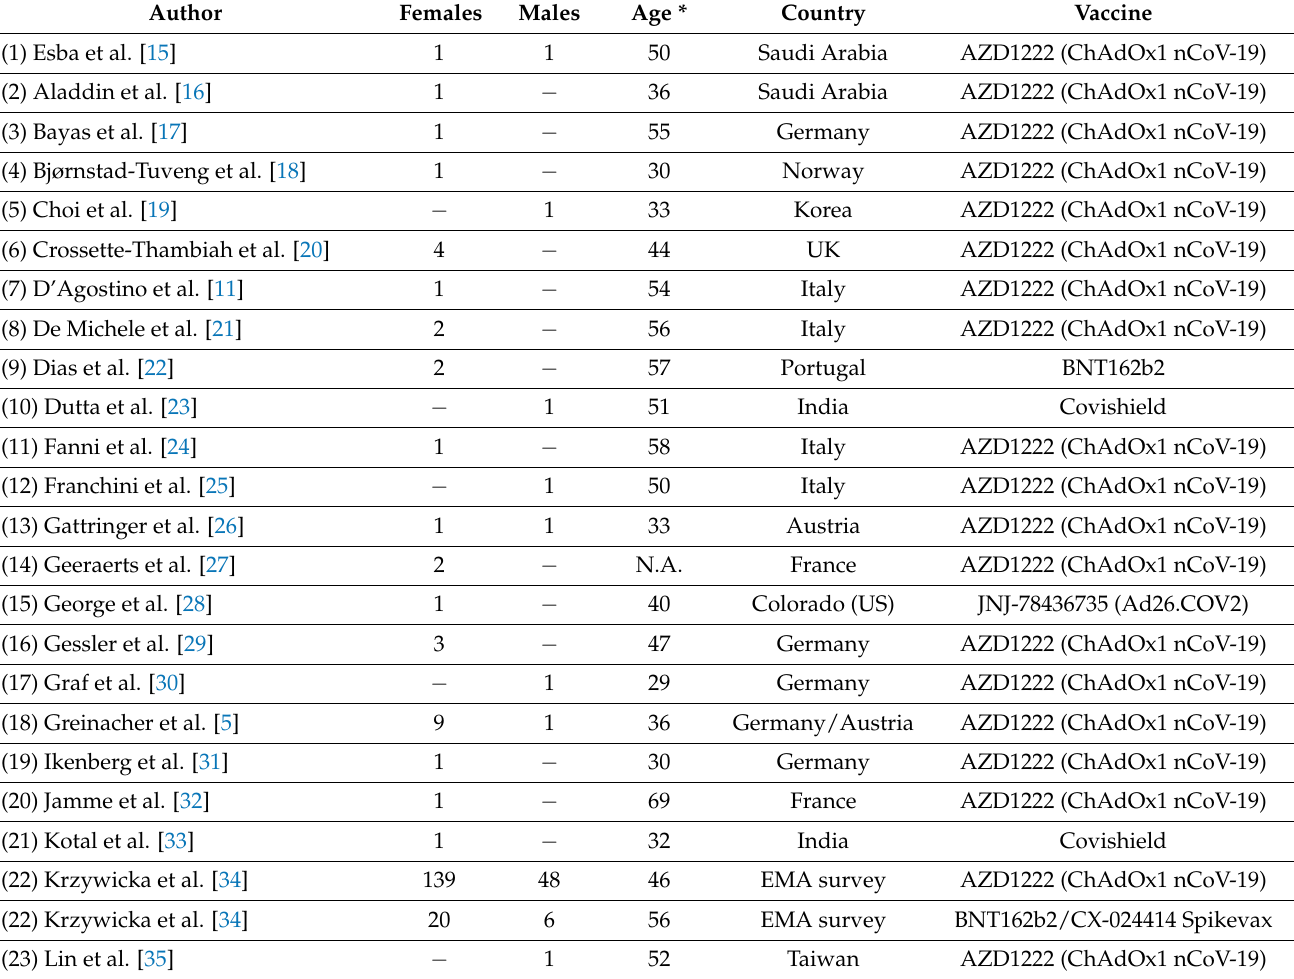
Table 1. Patient population from 41 studies from all over the world.